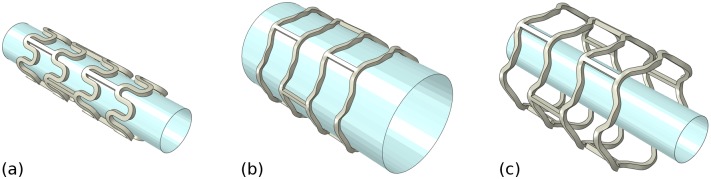
Finite element deployment simulation showing the stent in its (a) initial crimped state; (b) deployed (expanded) state and (c) final (recoiled) state.